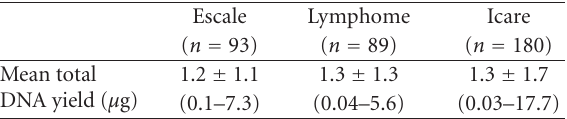
Table 3. Total DNA in µ g from three epidemiological studies obtained with the protocols Escale and Lymphome correspond to self-collection in a hard pack by children in the absence of an interviewer (Escale) or correspond to self-collection in a hard pack in the presence of an interviewer (Lymphome). The pro- tocol Icare allowed self-collection in adults in the presence of an interviewer. DNA was extracted according to QIAamp DNA blood MiniKit, QIAGEN, Courtaboeuf, France. The quantity of DNA was measured by fluorescence with